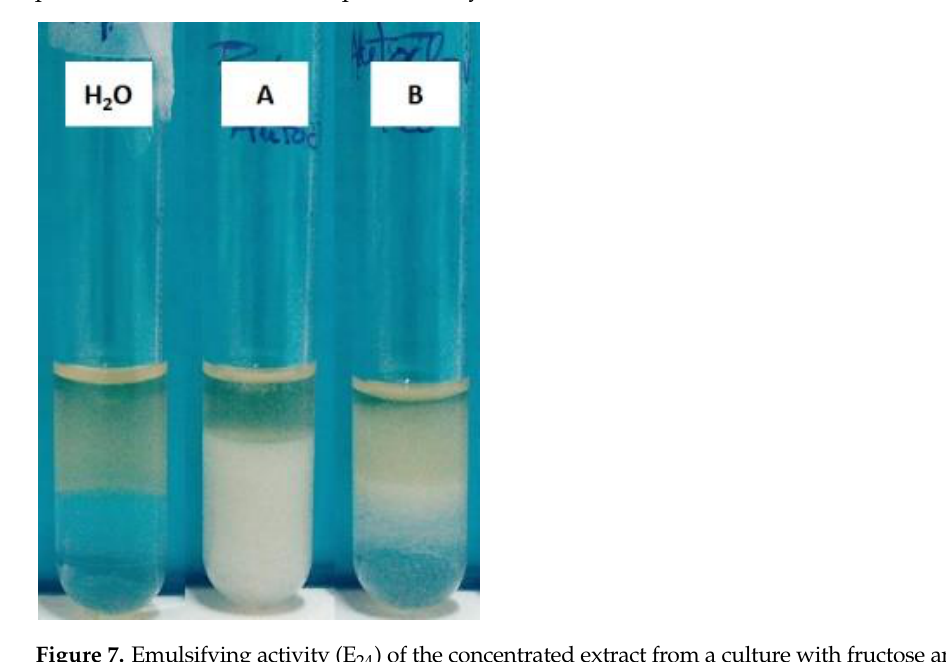
) of the concentrated extract from a culture with fructose and DBT 24